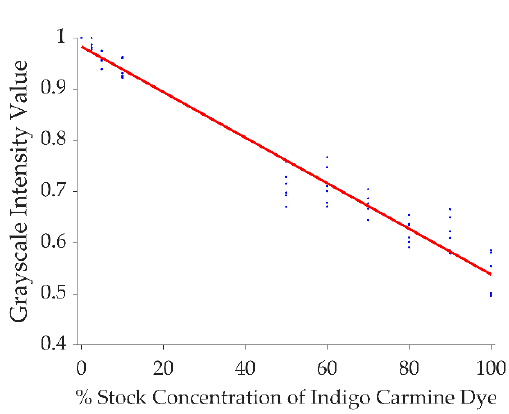
Figure 2. Grayscale intensity values plotted against 1% ( w / w ) indigo carmine dye dilutions in agarose gel used to determine the intensity threshold for converting grayscale images into binary